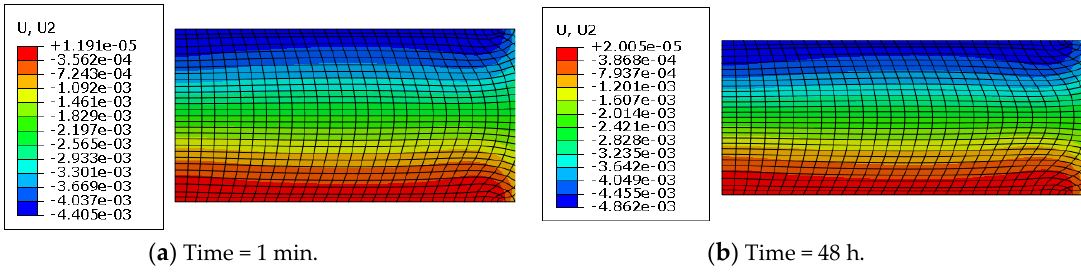
Figure 16. Axial creep deformation profiles at different times ( T = 23 °C; F = 1.5 kN).